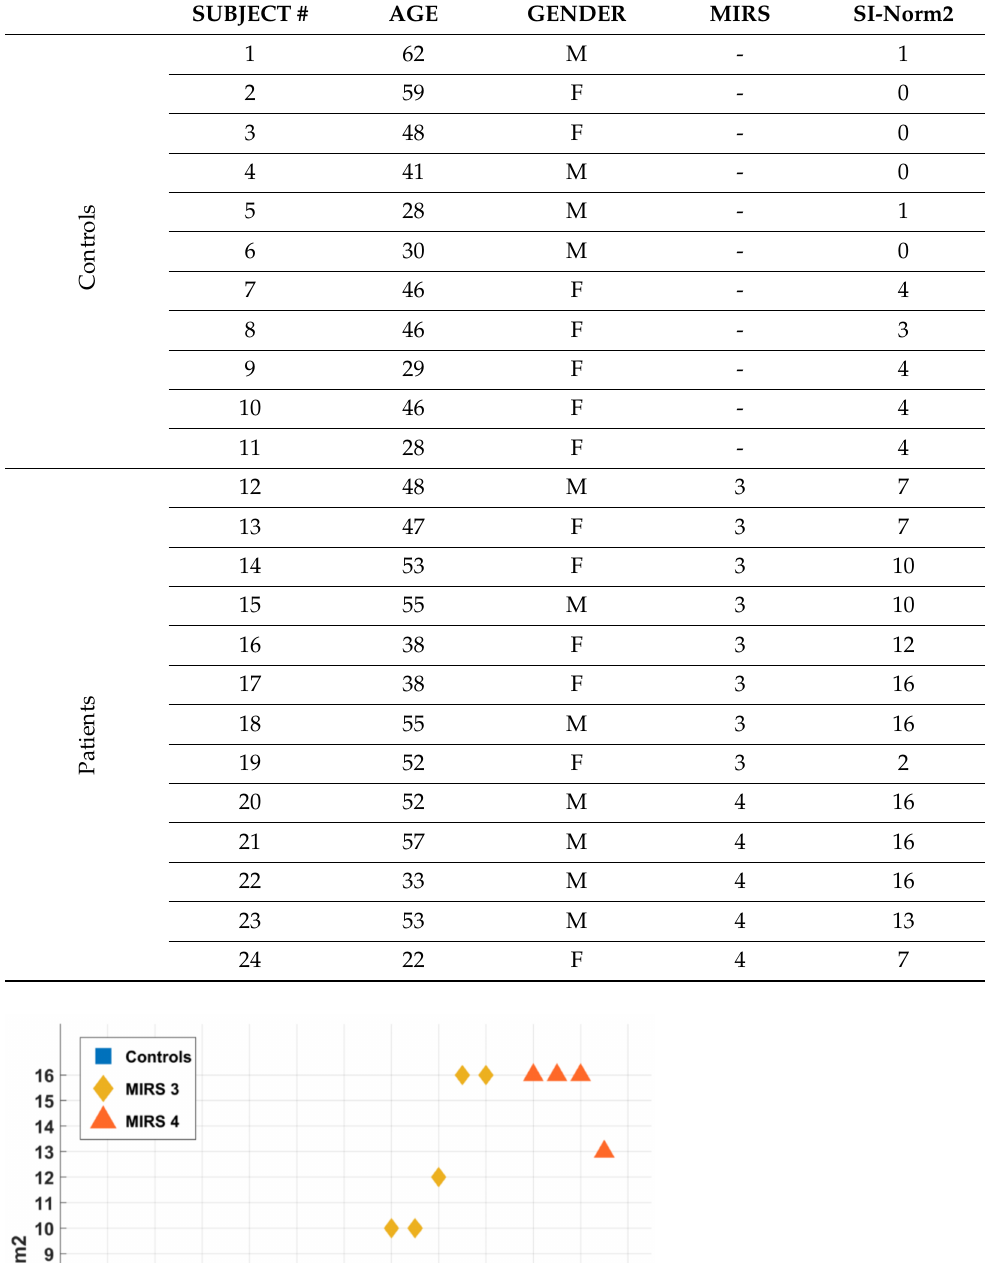
Table 4. Si-Norm2 results for the 11 controls and the 13 patients analyzed.